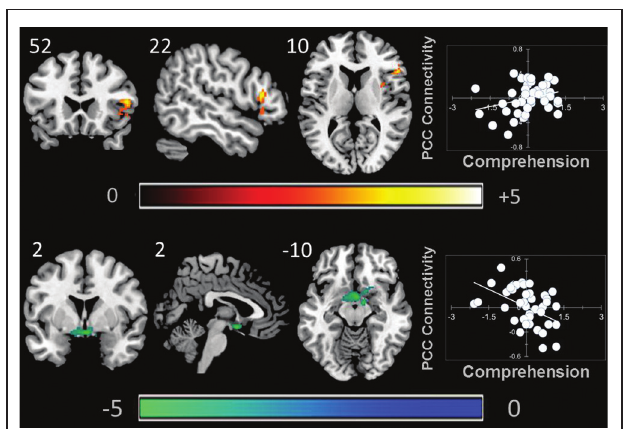
FIGURE 3 | Modulation of the connectivity pattern of the bilateral PCC by objective indicators of reading performance. These images were created using a cluster forming threshold of p < 0.01. Topological FDR ( q -value < 0.05) was used to correct for multiple comparisons. The scatter plots reflect the average correlation with the PCC for the peak voxel in each cluster. Each point is a single individual. Co-ordinates reflect the peak voxels for each cluster. All results are overlaid on a standard MNI template. Unthresholded statistical maps have been uploaded to NeuroVault.org and are available at